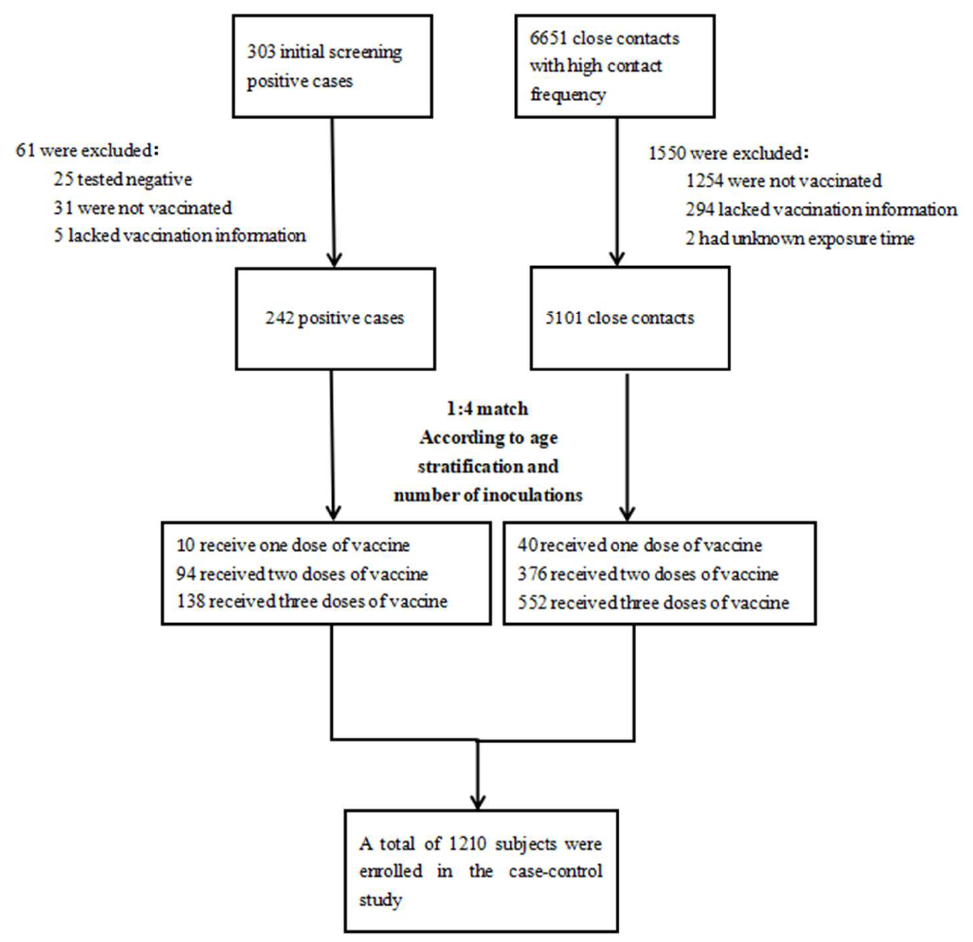
Figure 1. Screening process for the cases and controls.